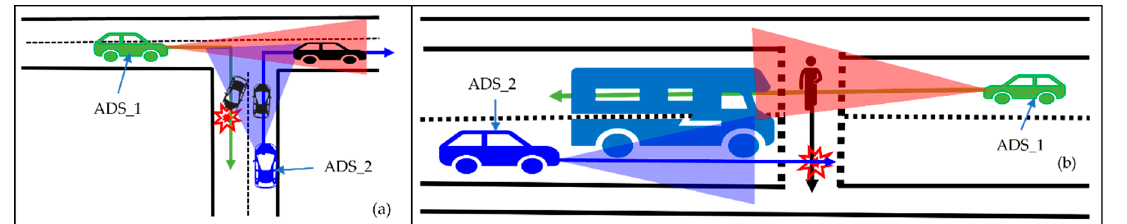
Figure 1. Occlusion in a real traffic scenario. ( a ) represents occlusion on T-junction, and ( b ) represents a hazardous scenario caused by occlusion.